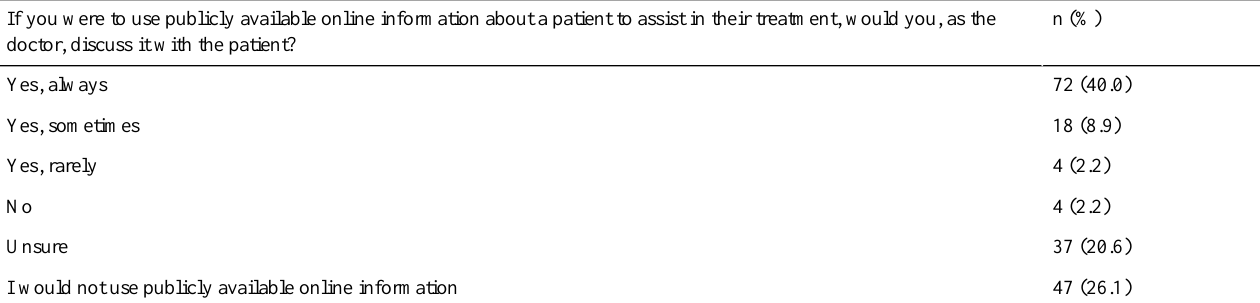
Table 4. Examples of online ethical dilemmas. UnsureNoYesDilemma eg, a blogger saying that sex without a condom is safe. “Googled” a patient to find more information about